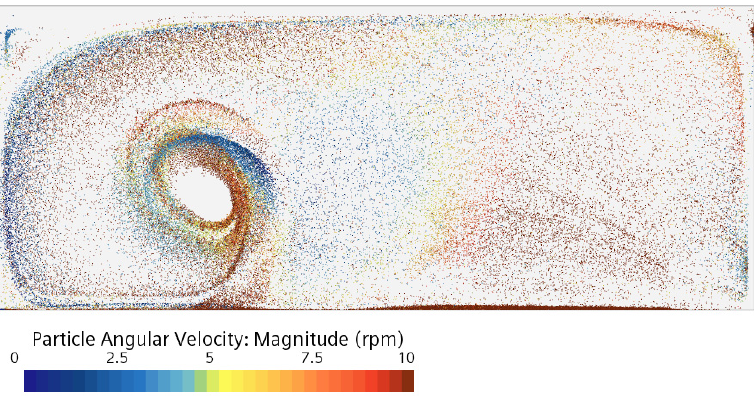
Figure 26. Location and angular velocity distribution of particles in c1.